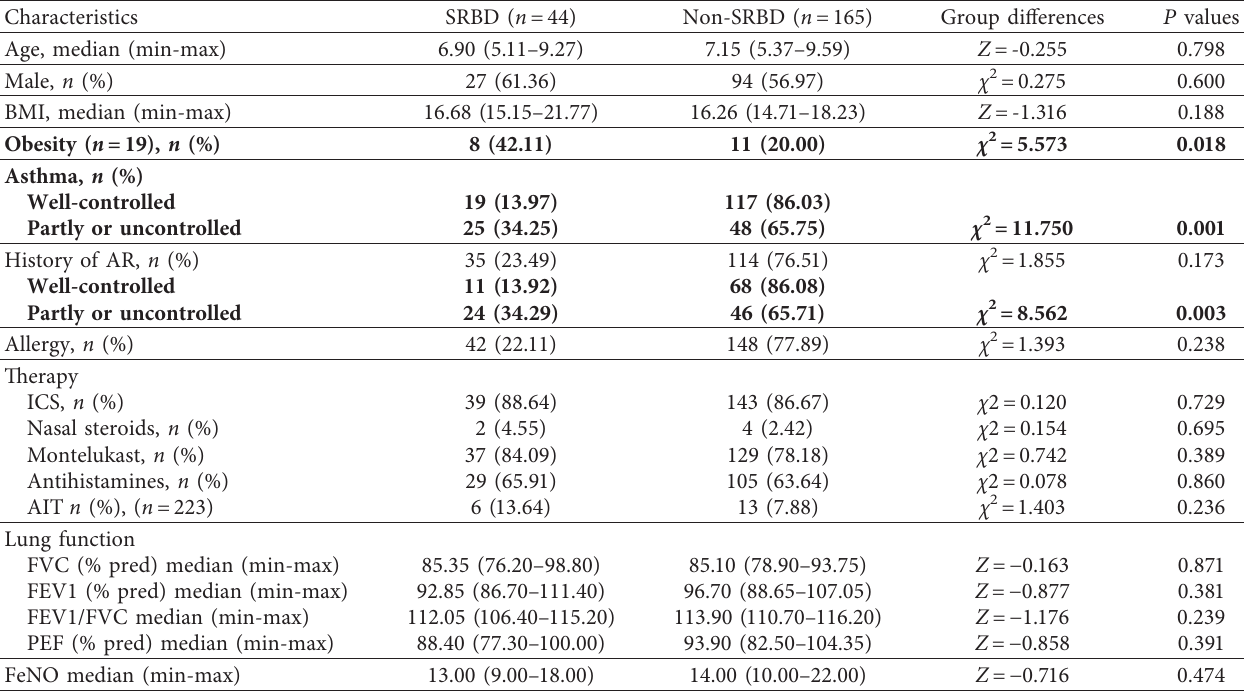
Table 2: Characteristics, comorbidities, and medications of enrolled children according to SRBD.